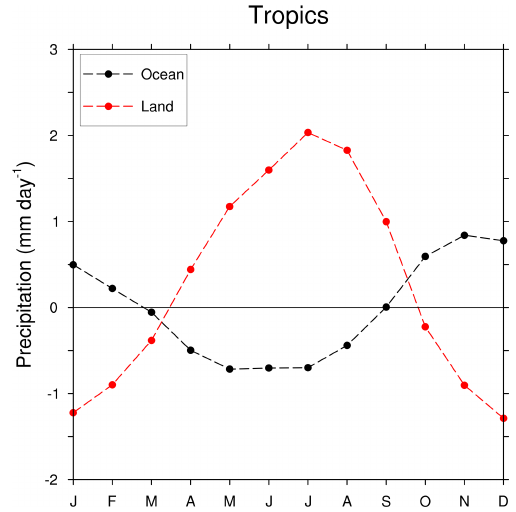
Figure 4. The difference in precipitation ( P min − P max ) for all the tropical land and ocean taken separately (30 ◦ S–30 ◦